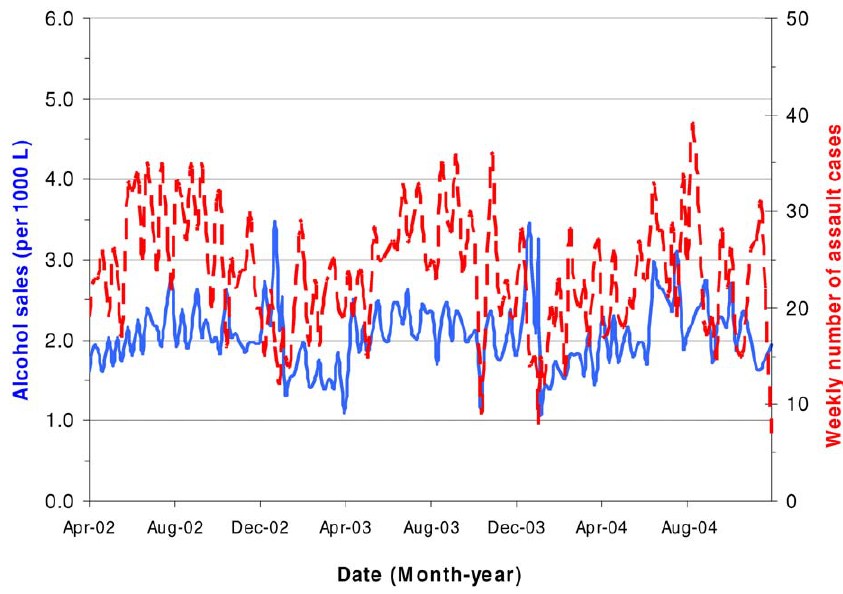
Figure 1. Mean Alcohol Sales (Blue) and Weekly Number of Hospitalized Assaults (Dashed